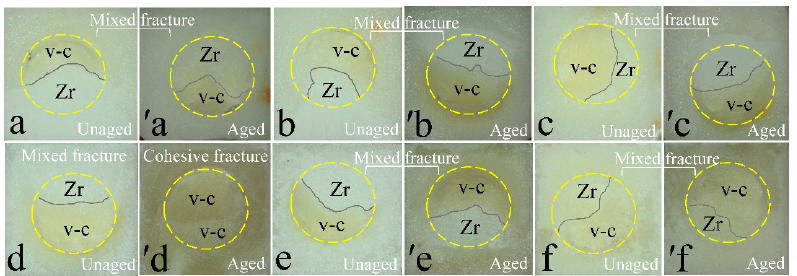
Figure 11. Fracture mode patterns shown under a stereomicroscope. The mixed fracture type was the common fracture among the studied groups in unaged and aged conditions: milling ( a , (cid:48) a ), grinding ( b , (cid:48) b ) sandblasting ( c , (cid:48) c ), L3 ( d , (cid:48) d ), L4 ( e , (cid:48) e ), and L5 ( f , (cid:48) f ) groups. The letters ( a – f ) and ( (cid:48) a – (cid:48) f ) refer to unaged and aged conditions, respectively. The specimens in the “aged condition” were stored in distilled water for six weeks at 37 ◦ C. The yellow circles show the border of the cylindrical veneer ceramics. The grey lines show the fracture Table 9. Tests of between-subject effects to show the influence of treatment techniques, aging condition, and the impact of tretment-aging; dependent variable is shear bond strength values.